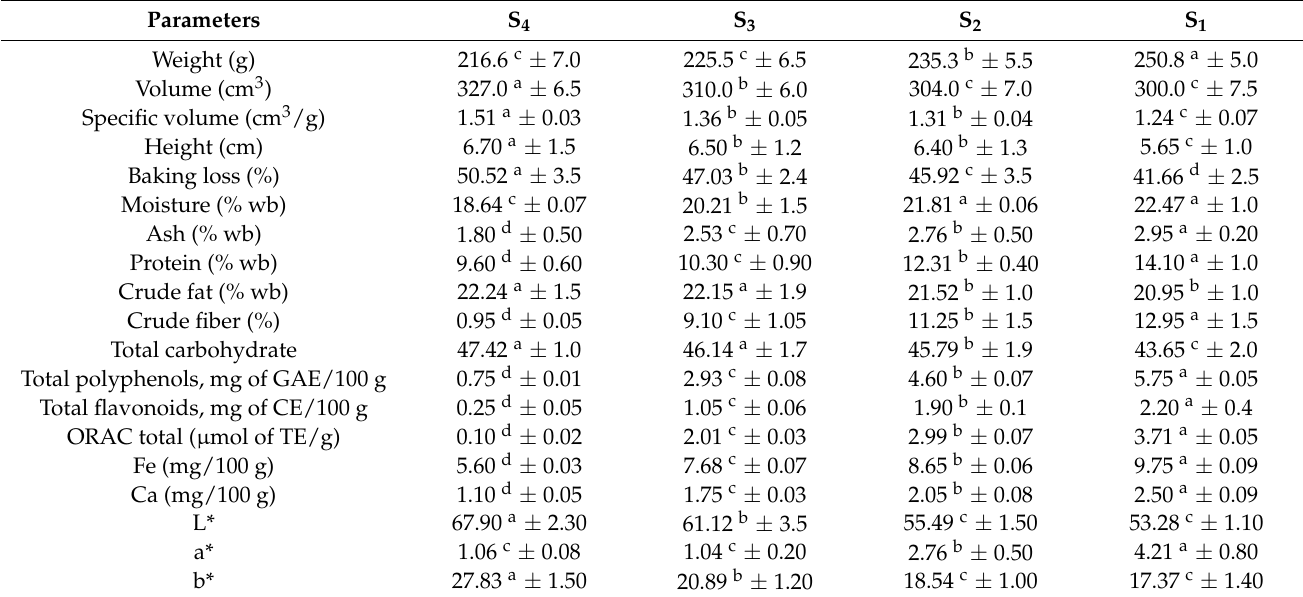
Table 3. Effect of addition of Aloe Vera leaf powder (ALP) on physical and nutritional properties of plain (loaf) cakes.